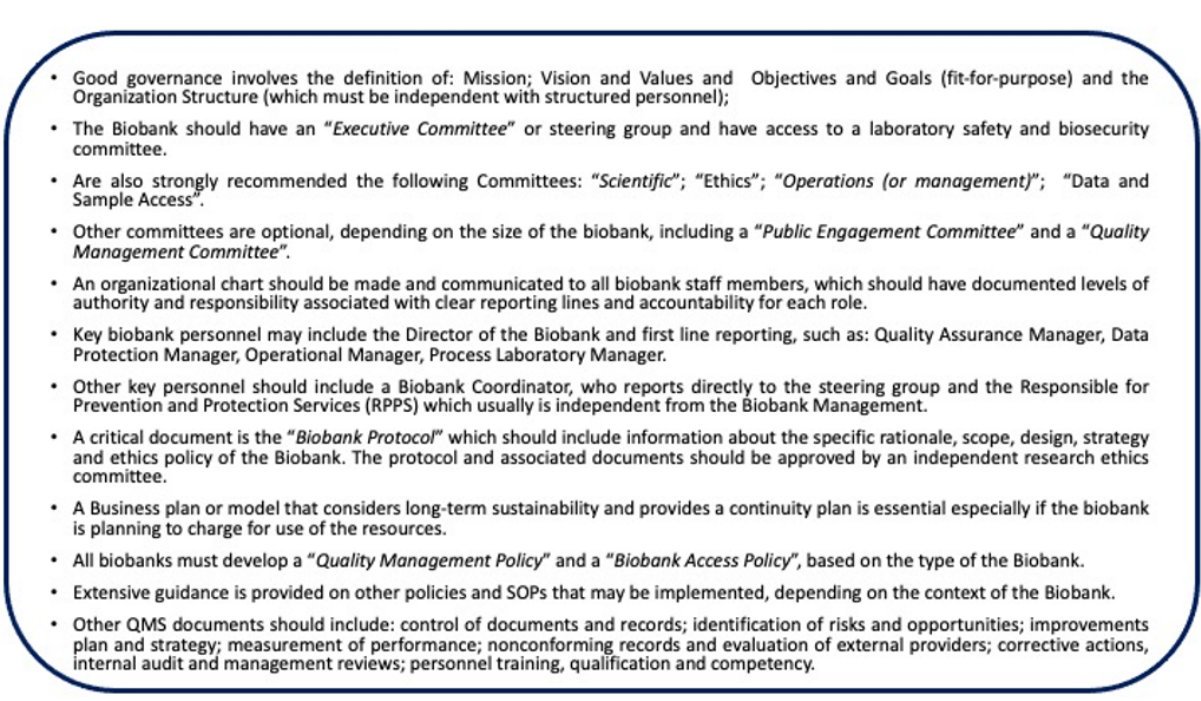
Figure 1. Biobank governance the key elements.